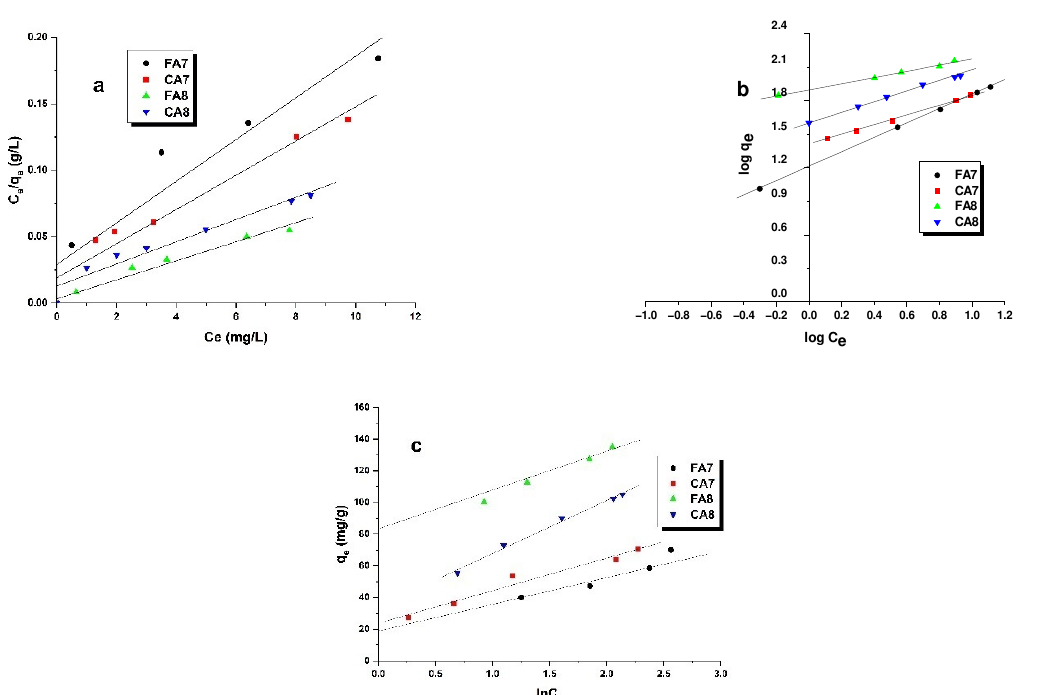
Figure 5. Linear fitting of methyl red sodium salt adsorption isotherms on biocarbon adsorbents to Langmuir ( a ), Freundlich ( b ) and Temkin ( c ) models.